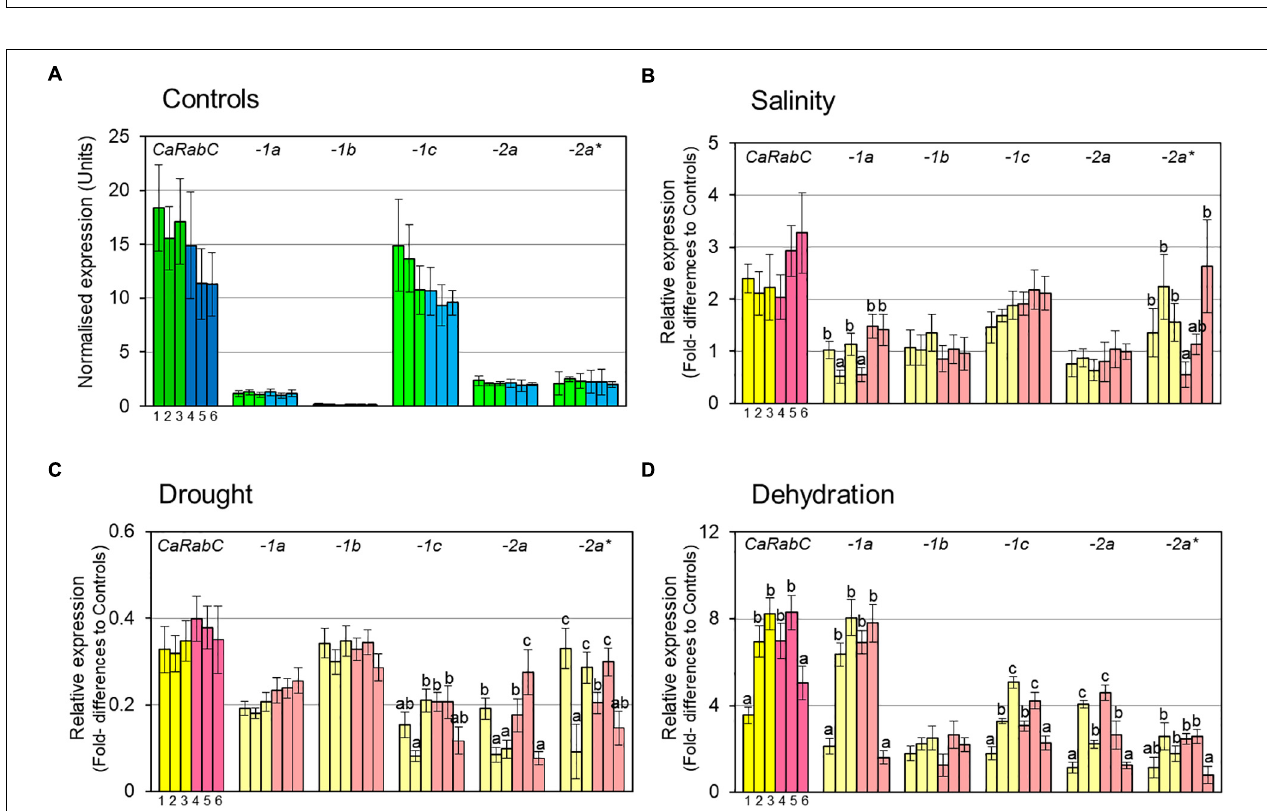
FIGURE 3 | RT-qPCR analysis of CaRabC gene family expression in chickpea leaves: (A) In favorable, non-stressed conditions (Controls) for 3 Kabuli and 3 Desi (dark green and dark blue, respectively); and the relative gene expression compared to Controls under: (B) Gradual salt stress application, 150 mM NaCl, 7 days; (C) Slowly developing drought in pots with soil, 12 days; and (D) Rapid dehydration of detached leaves, 6 h, room temperature. All isoforms of CaRabC gene combined (darker colors) and the five separate isoforms (lighter colors) of the CaRabC-1a , -1b , -1c , -2a and -2a ∗ (for corresponding gene family) were analyzed separately. Each set contained six chickpea accessions, including three Kabuli ecotypes, shown in yellow ( 1 , Yubileiny; 2 , ICC-7255; and 3 , ICC-4841), and three Desi ecotypes, shown in pink ( 4 , ICC-1392; 5 , ICC-4918; and 6 , ICC-12726). Data were normalized using an average for two reference genes, calculated with ANOVA, and are presented as means for three biological and two technical replicates ± SE, shown as error bars. Significant differences (at least for P > 0.95) for each gene isoform and within each set of chickpea accessions are shown by different letters according to ANOVA tests.